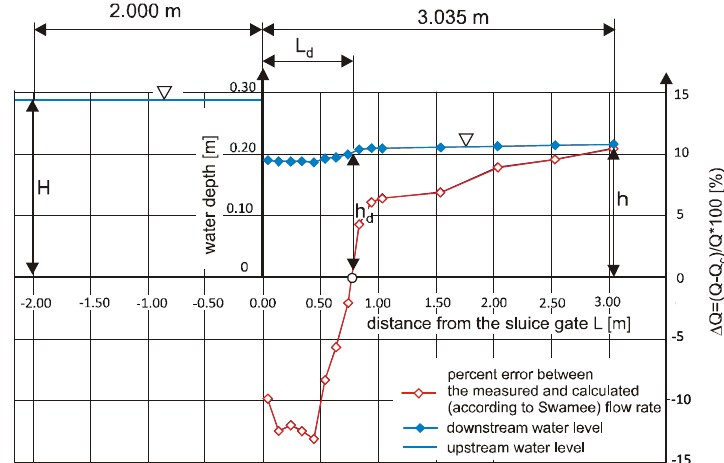
Figure 5. Procedure to determine the measurement cross-section for downstream water depth h d , ensuring that the discharge calculated, using Equation (6), is equal to the observed one; L c —the distance from the gate to the measurement cross-section.